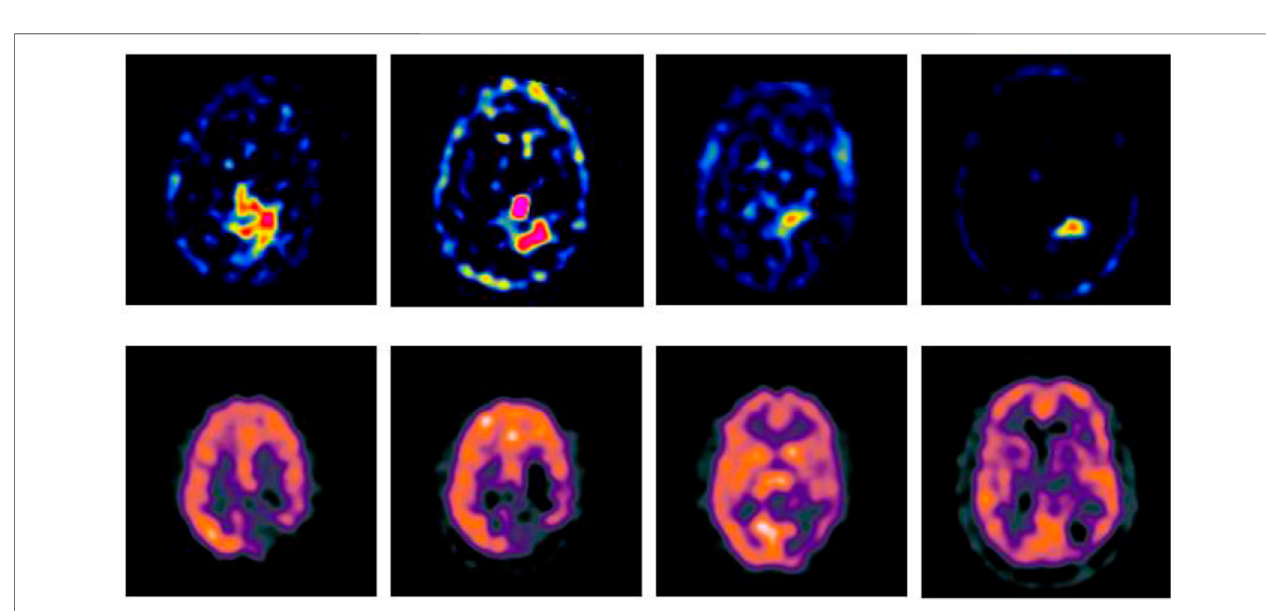
FIGURE 2 | Source